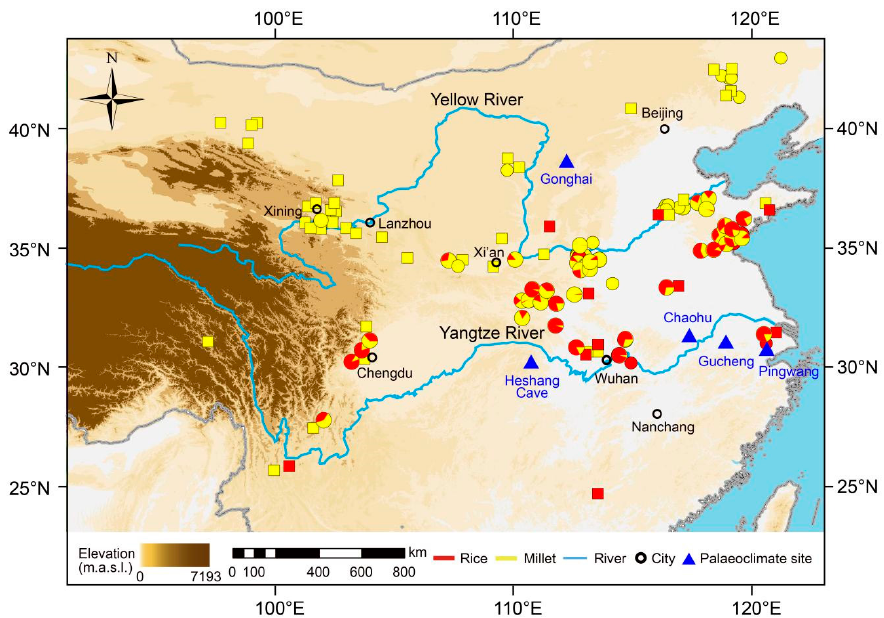
Figure 3. The spatial pattern of crop macro-fossils from sites dated between 5000-4000 BP in China. Squares represent sites without detailed archaeobotanical data; circles represent sites with detailed archaeobotanical data.